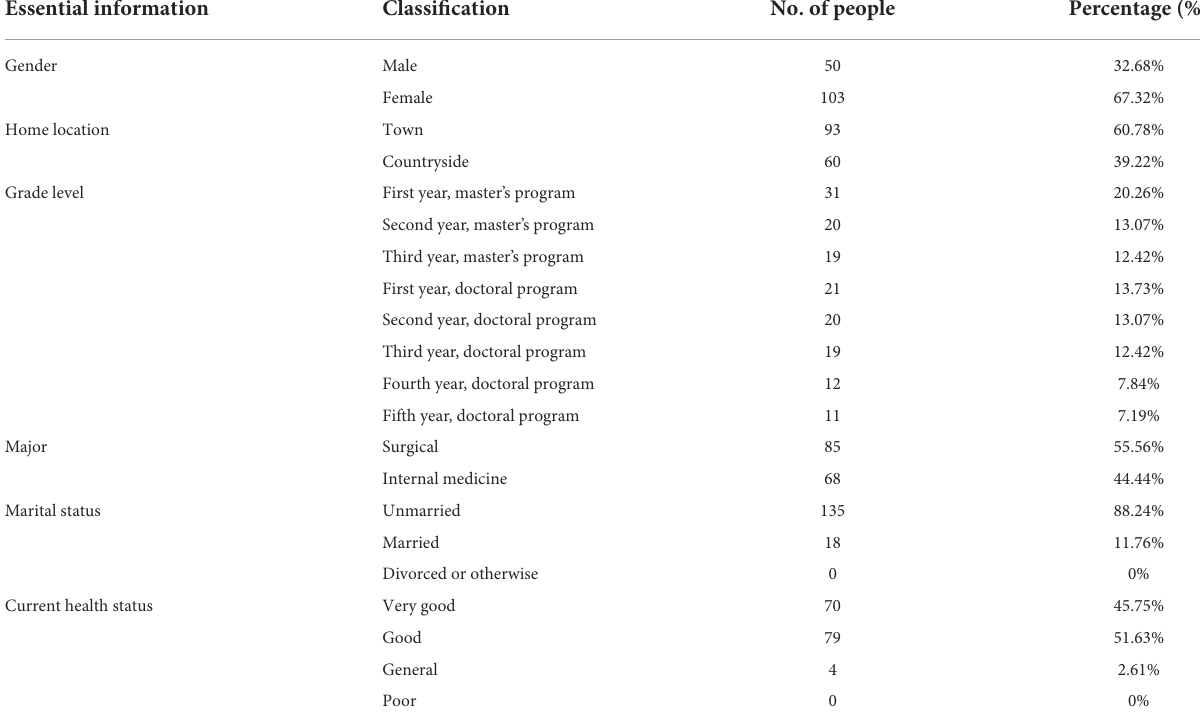
TABLE 1 Demographic characteristics of the study